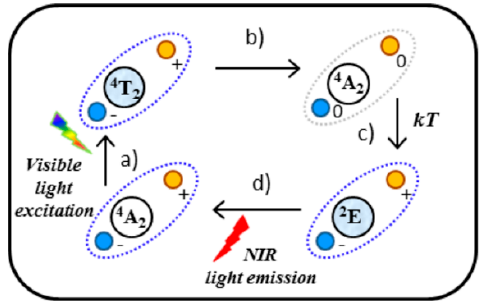
Figure 15. Proposed mechanism of PeL in ZGO:Cr induced by excitation below 3.1 eV. Cr N2 is represented by its states ( 4 T 2 , 4 A 2 or 2 E). Blue and yellow spheres represent the two opposite charge antisite defects. Steps: ( a ) optical excitation to the Cr 3 + 4 T 2 excited level; ( b ) relaxation to the the Cr 3 + 4 A 2 ground level, charge migration, and carriers trapping by neighboring antisite defects of opposite charges; ( c ) thermal release of e - -h + pairs and trapping by Cr 3 + ; ( d ) the Cr 3 + 2 E → 4 A 2 in the NIR. Reprinted with permission from [244]. Copyright (2013) American Chemical Society.